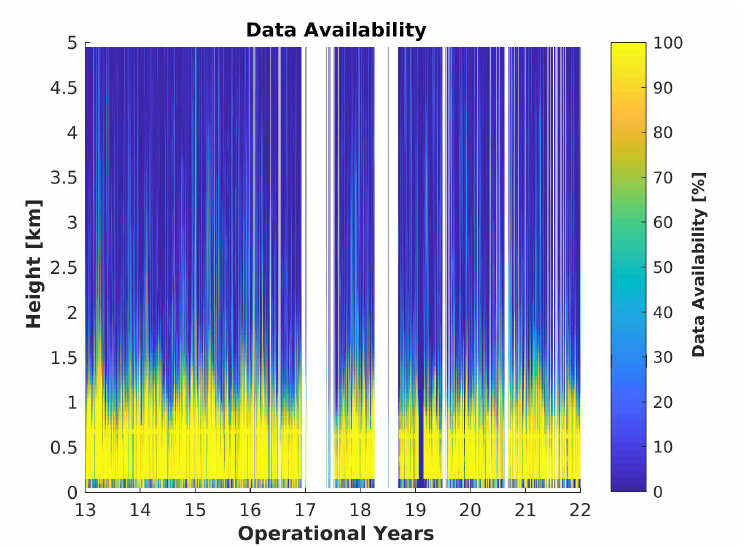
Figure 2. Availability of windlidar data in percent for the entire measurement time. The shown data are already averaged over 10 min.